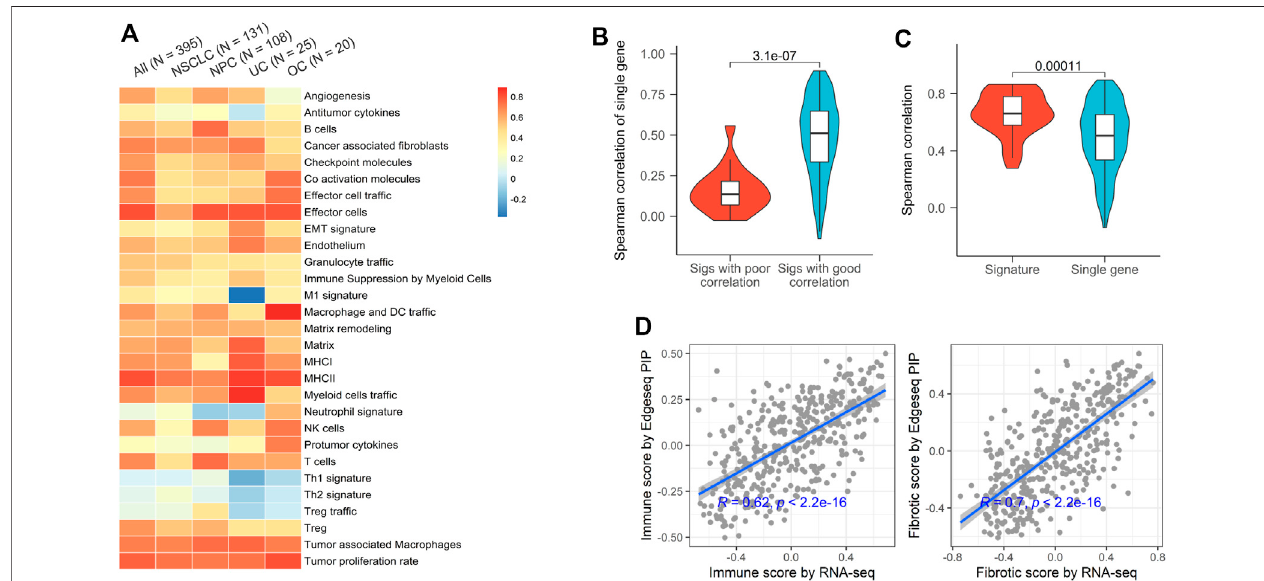
FIGURE 2 | Concordance of EdgeSeq PIP and RNA-seq for TME characterizing signatures. (A) Heatmap showing the Spearman correlation coef fi cients of 29 TME-characterizing signatures between EdgeSeq PIP and RNA-seq. Columns represent the overall correlation and correlation in each major cancer type. (B) Violin plots showing the gene-wise Spearman correlation coef fi cients of genes in poor and well correlated signatures. (C) Violin plots showing the distribution of signature- derived and gene-derivedSpearman correlation coef fi cients (between EdgeSeq PIPand RNA-seq). (D) Scatterplot showingthe correlationof immune scores (left) and fi brotic scores (right) estimated by EdgeSeq PIP and RNA-seq